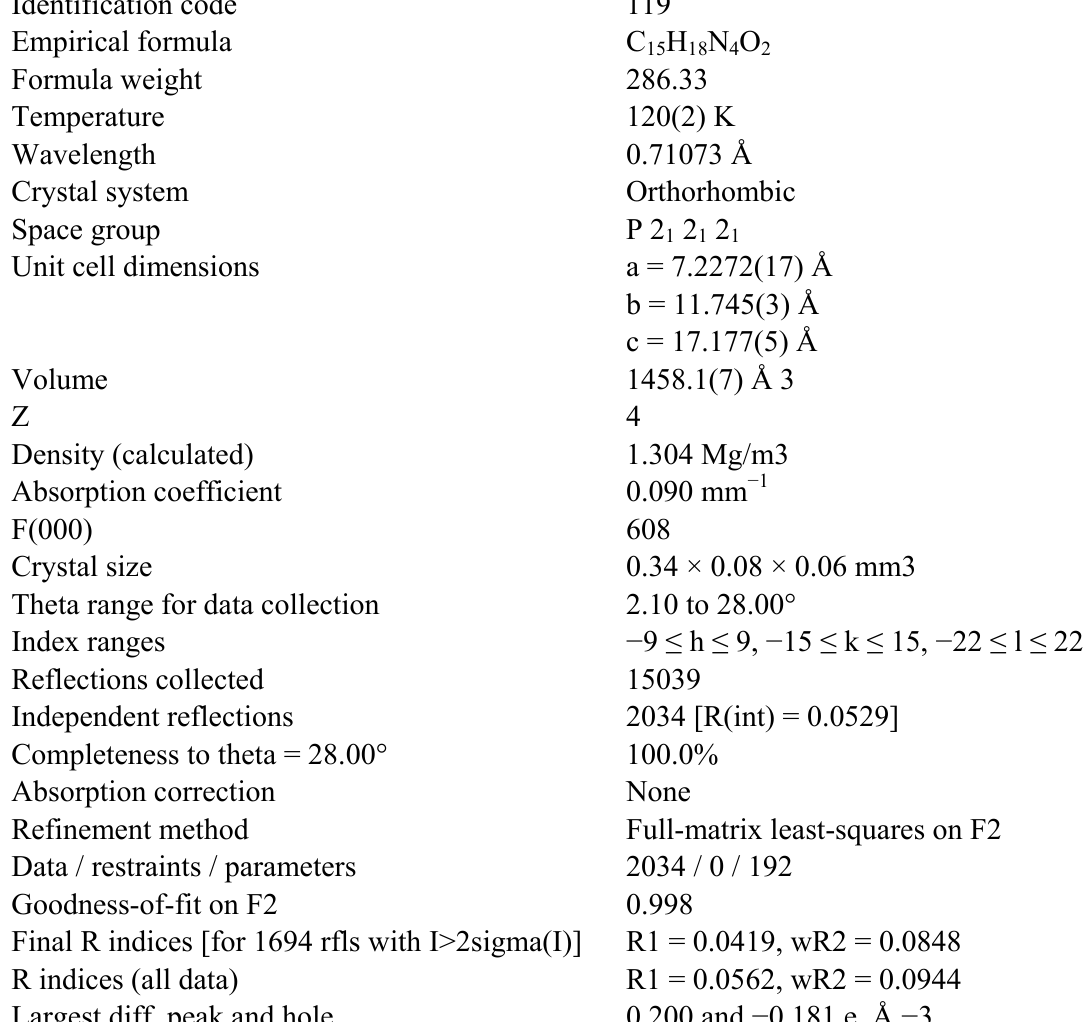
Table 1. Crystal data and structure refinement for compound 1